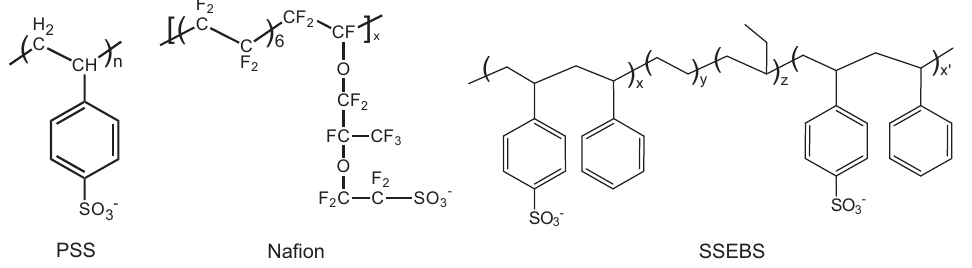
Figure 4 Representative cation exchange polymer